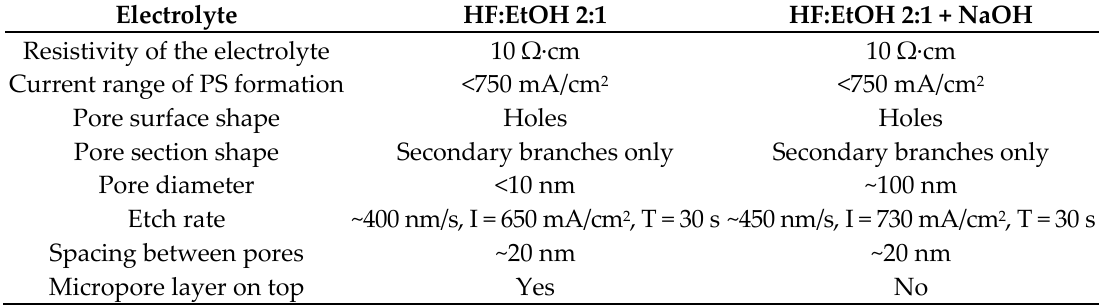
Table 2. Influence on pore morphology of fabrication parameters for a resistivity of 0.001–0.005 Ω∙ cm.